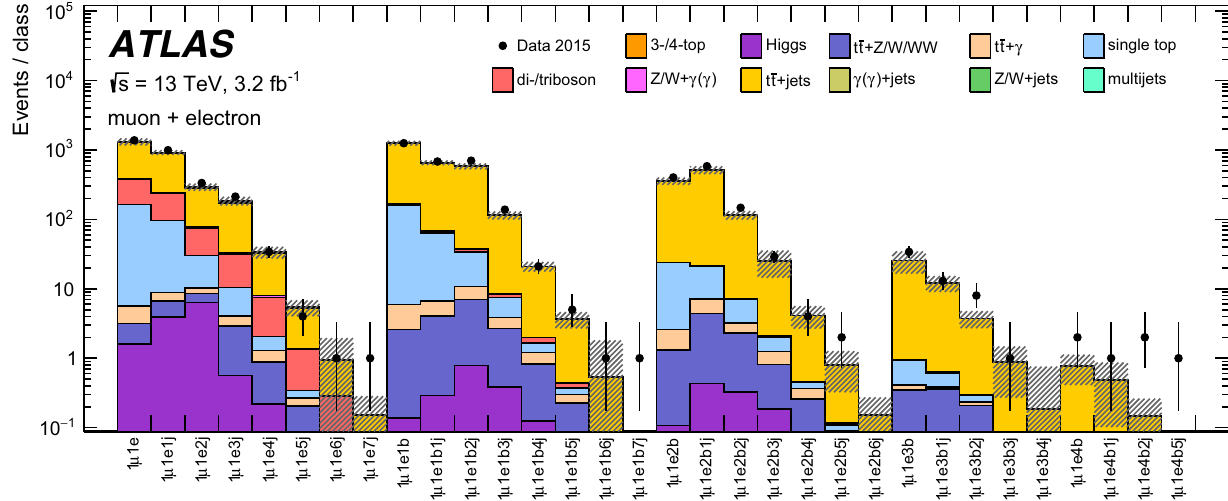
Fig. 14 The number of events in data, and for the different SM back- ground predictions considered, for classes with one muon, one electron and ( b -)jets (no photons or E miss ). The classes are labelled according T